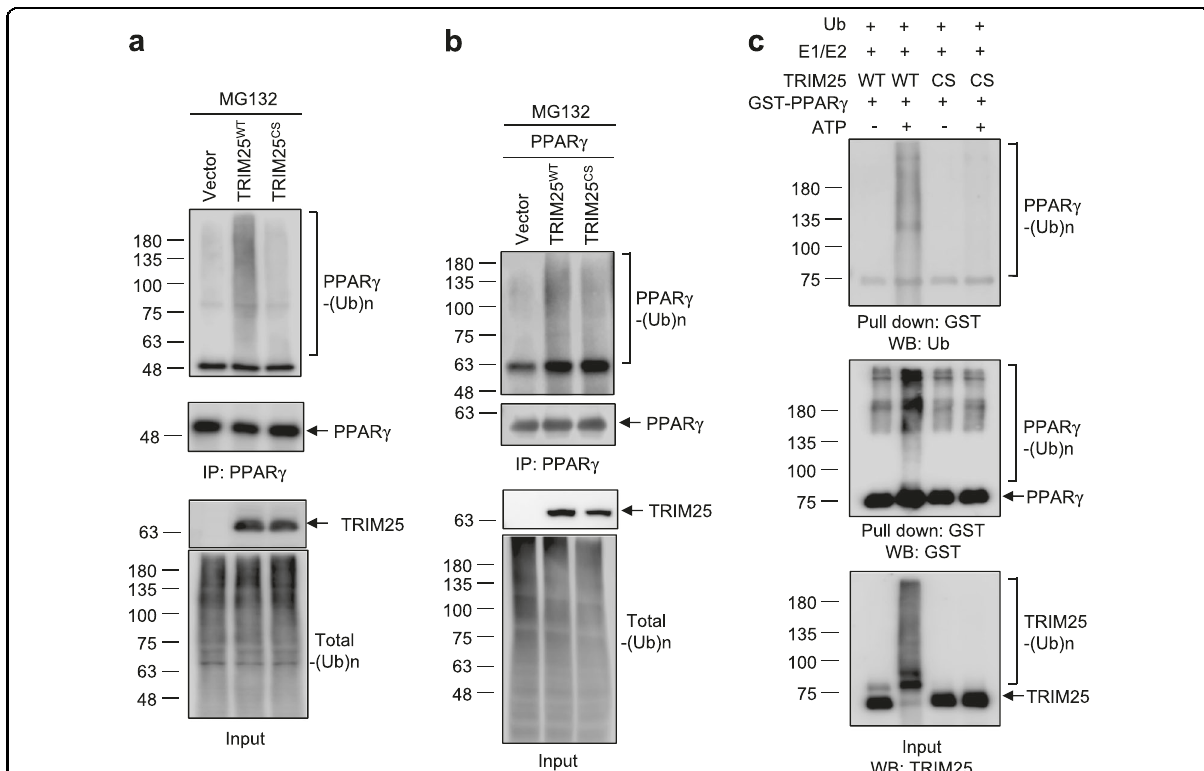
Fig. 4 TRIM25 mediates the ubiquitination of PPAR γ through its E3 ligase activity. a 3T3-L1 cells were stably expressed with TRIM25 WT or TRIM25 CS and differentiated for 6 days. Cells were treated with MG132 for 6 h. Cell lysates were incubated with an α -PPAR γ antibody, and ubiquitination of PPAR γ was analyzed by western blotting. b HEK-293 cells were transfected with TRIM25 WT or TRIM25 CS . Cell lysates were incubated with an α -FLAG antibody, and ubiquitination of PPAR γ was analyzed by western blotting. c Ubiquitination of PPAR γ by TRIM25 in vitro. Puri fi ed GST- tagged PPAR γ was incubated with E1, E2, ubiquitin (Ub), TRIM25 WT , or TRIM25 CS in the absence and presence of ATP as indicated. Ubiquitination of PPAR γ was analyzed by western blotting using the indicated